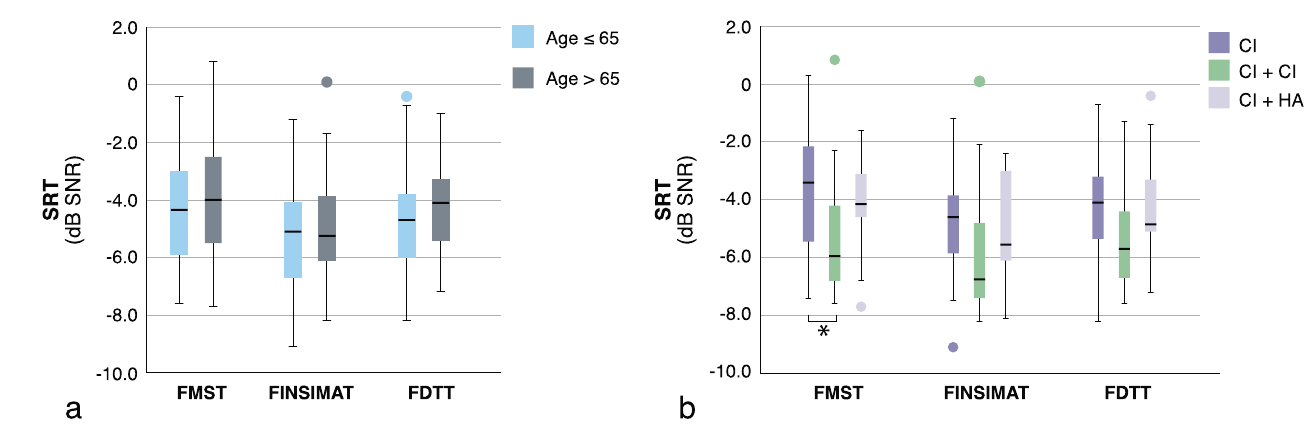
Figure 3. Comparisons between the different age groups ( a ), and device modalities ( b ). The asterisk notes the only statistically significant difference between the results. FMST, Finnish matrix sentence test, FINSIMAT, Finnish simplified matrix sentence test; FDTT, Finnish digit triplet test; CI, cochlear implant; HA, hearing aid.